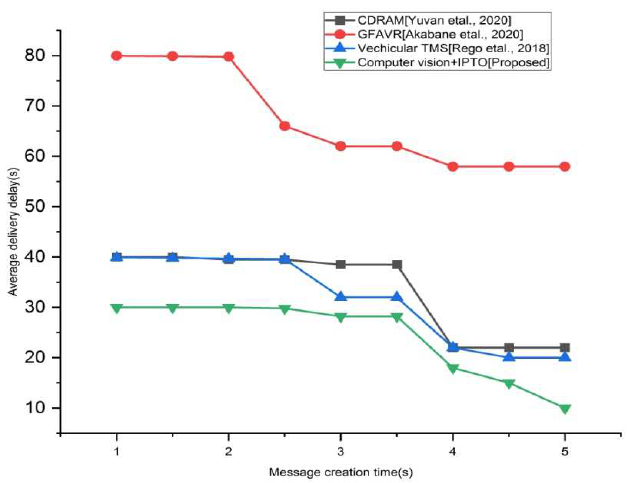
Figure 4. Average delivery delay vs. different message interval for the existing and proposed method.